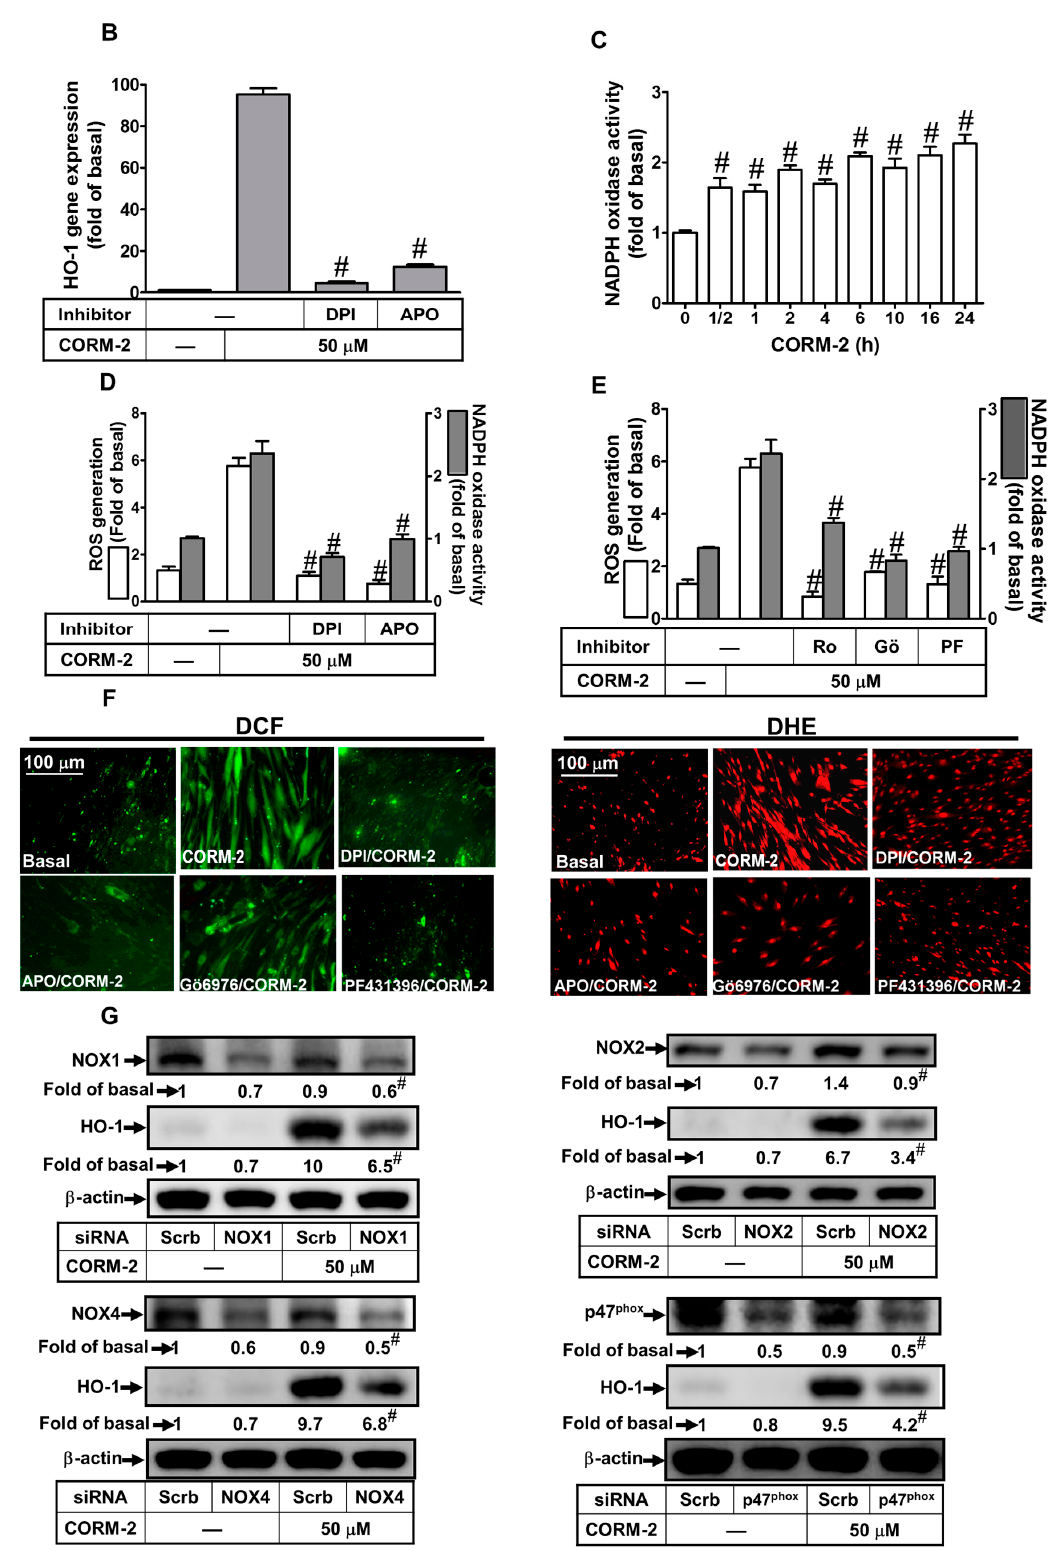
Figure 3. Nicotinamaide adenine dinucleotide phosphate (NADPH) oxidase-dependent ROS generation contributes to CORM-2-induced HO-1 expression in HTSMCs. ( A ) Cells were pretreated without or with diphenyleneiodonium (DPI) or apocynin (APO) for 1 h before exposure to CORM-2 for 24 h. The protein levels of HO-1 and β -actin (served as an internal control) were determined by